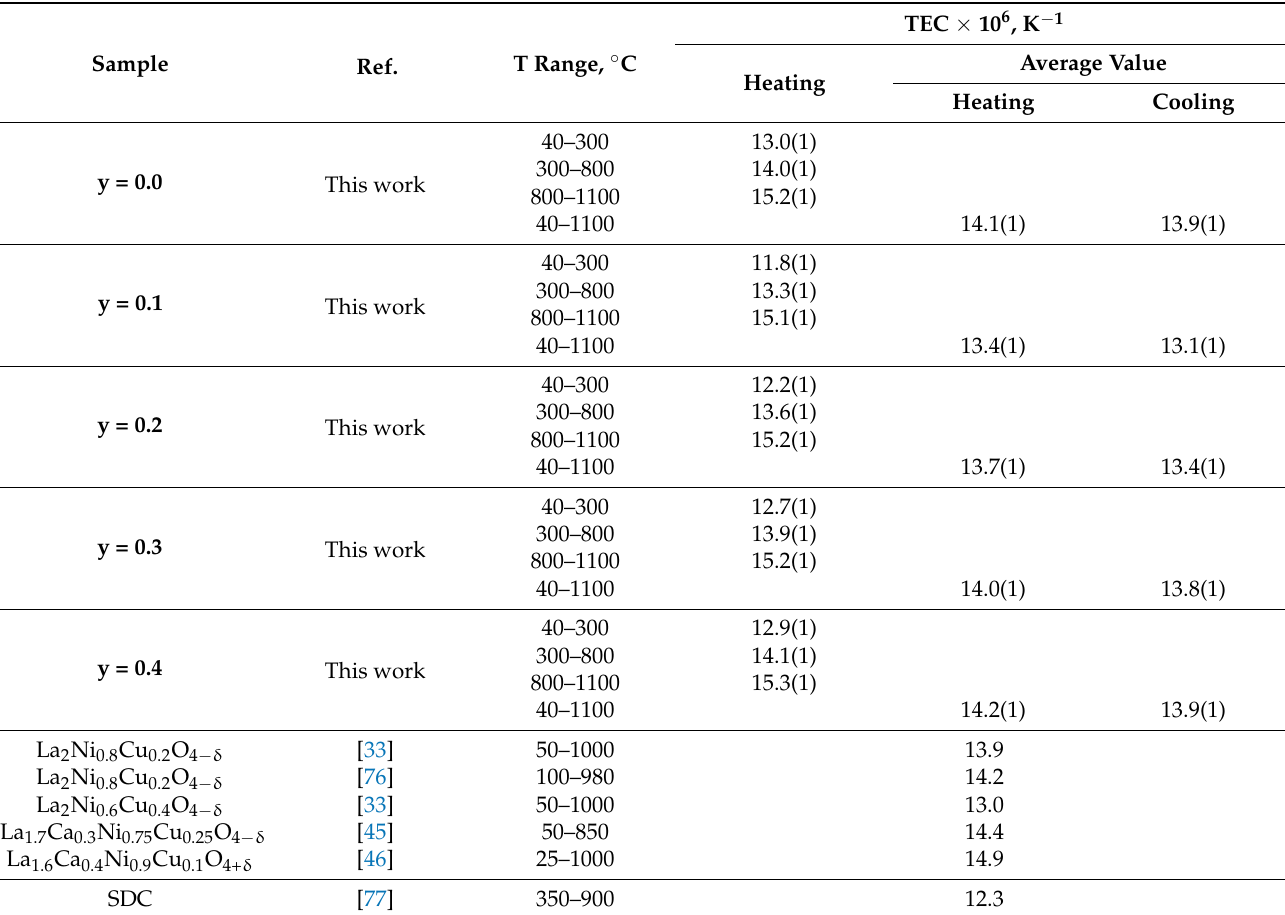
Table 4. Average TEC values for the La 1.7 Ca 0.3 Ni 1 − y Cu y O 4+ δ ceramics and other Cu- and Ca-